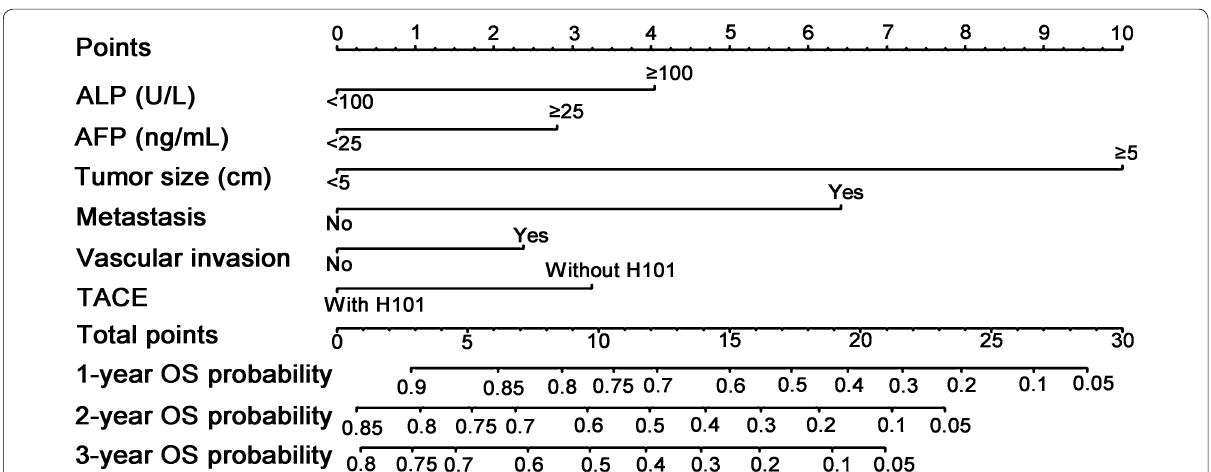
Fig. 2 Nomogram‑predicted probabilities of the 1‑, 2‑, and 3‑year OS of patients with intermediate to advanced HCC who received TACE with or without H101. The nomogram is used by adding the points identified on the “Point” scale for six variables. The sum is located on the “Total points” scale, and a line is drawn downward to the survival axes to determine the probability of 1‑, 2‑, and 3‑year OS. ALP alkaline phosphatase, AFP alpha‑ fetoprotein